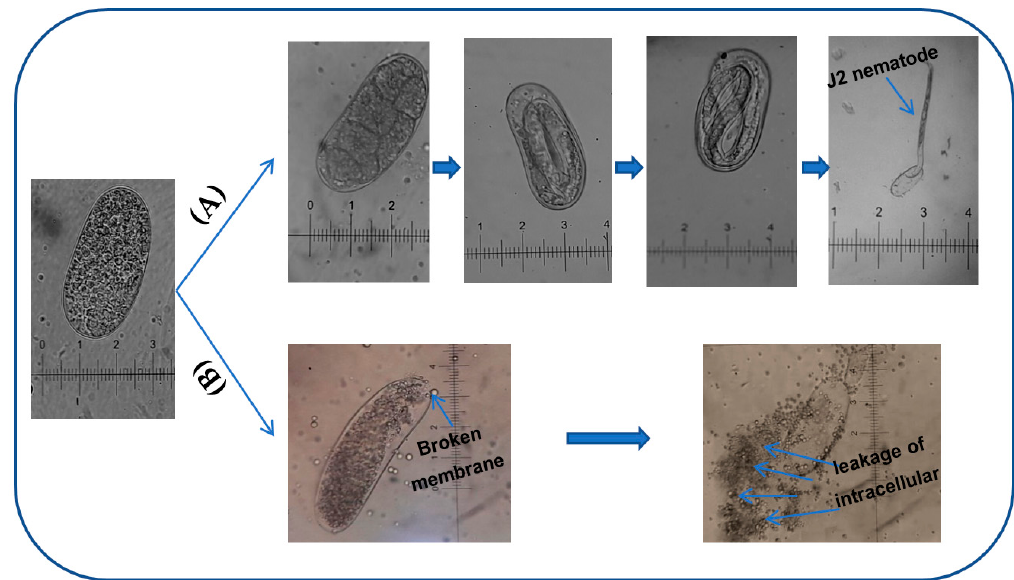
Figure 11. The nematode egg develops normally, creating J2 nematode in control samples ( A ) and the egg was broken, causing the leakage of intracellular ingredients after the treatment by hemi ‐ pyocyanin and crude pigments ( B ).